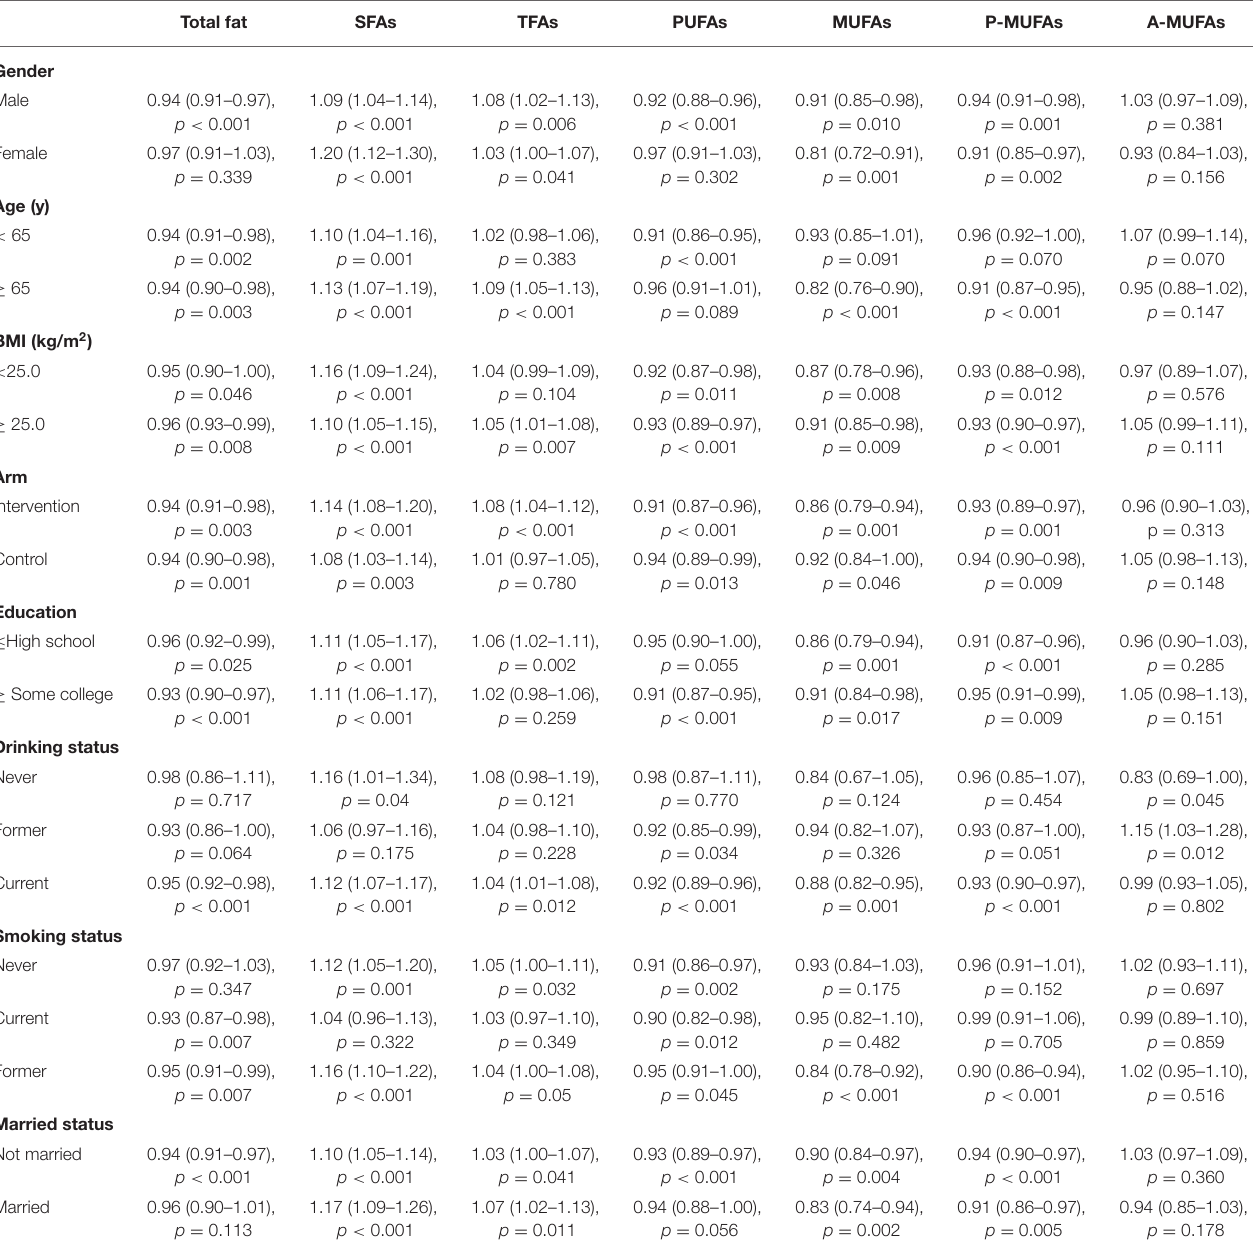
TABLE 3 | Subgroup analyses of the associations of total and specific dietary fat intake with total mortality. Total fat SFAs TFAs PUFAs MUFAs P-MUFAs